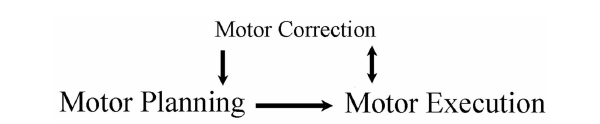
FIGURE 1 | Framework of review . A movement is planned and then executed.The executed movement is monitored, as online corrections aide ongoing movements and offline corrections aide the planning of subsequent